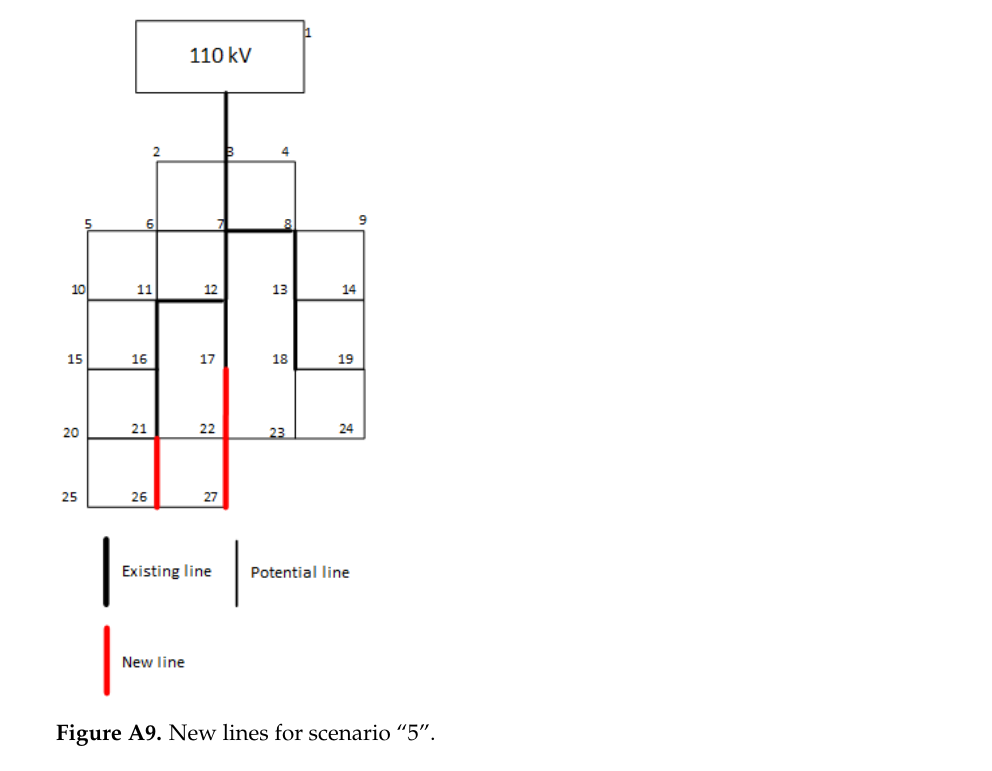
Figure A8. New lines for scenario “4”.